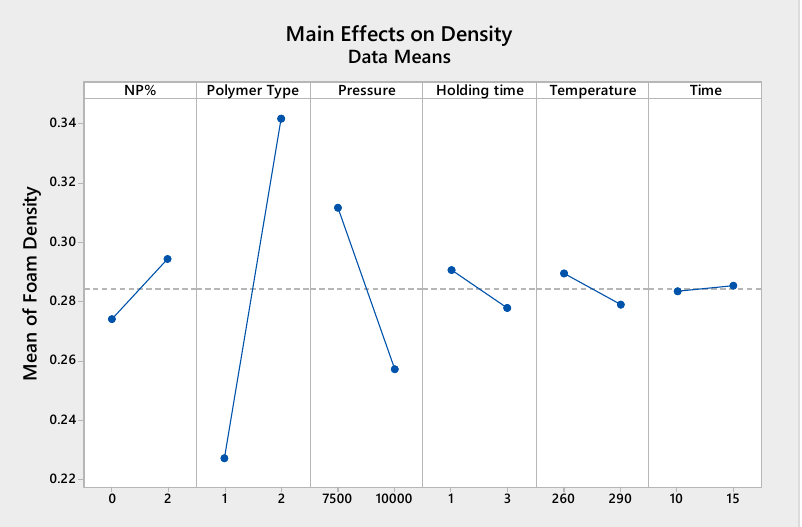
Figure 14. Effect of all of the parameters on the foam density .